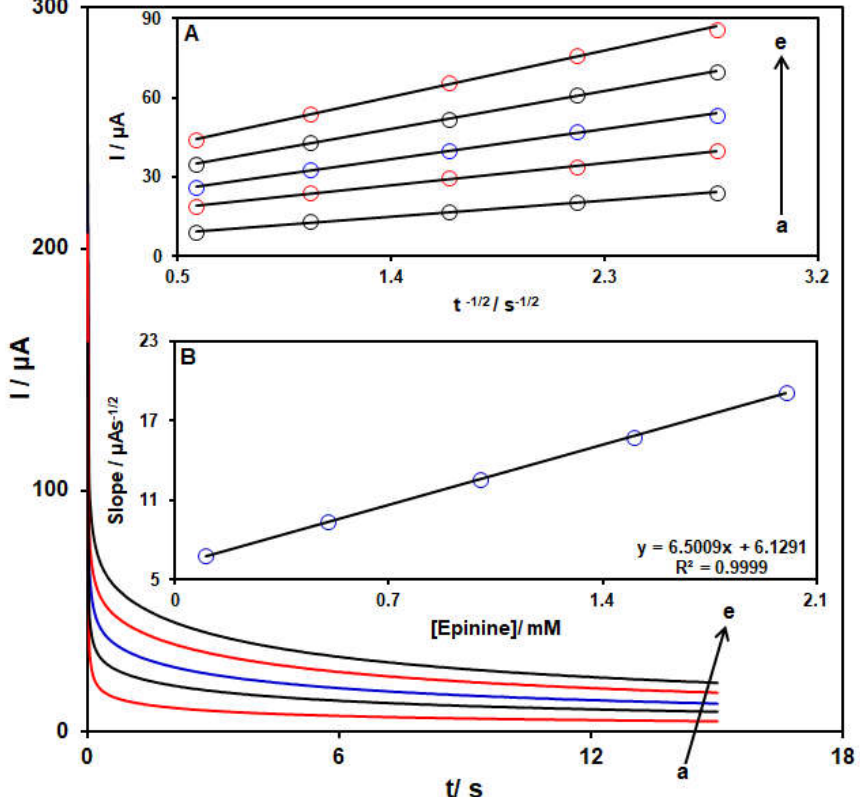
Figure 8. Chronoamperograms captured for the NiCo-MOF/SPGE in the exposure to variable epinine concentrations, a–e correspond to (a) 0.1, (b) 0.5, (c) 1.0, (d) 1.5, and (e) 2 mM of epinine in PBS (pH 7.0, 0.1 M). Insets: ( A ): Plots of I vs. t −1/2 from chronoamperograms a–e. ( B ) Plot of straight lines slope vs. epinine level.